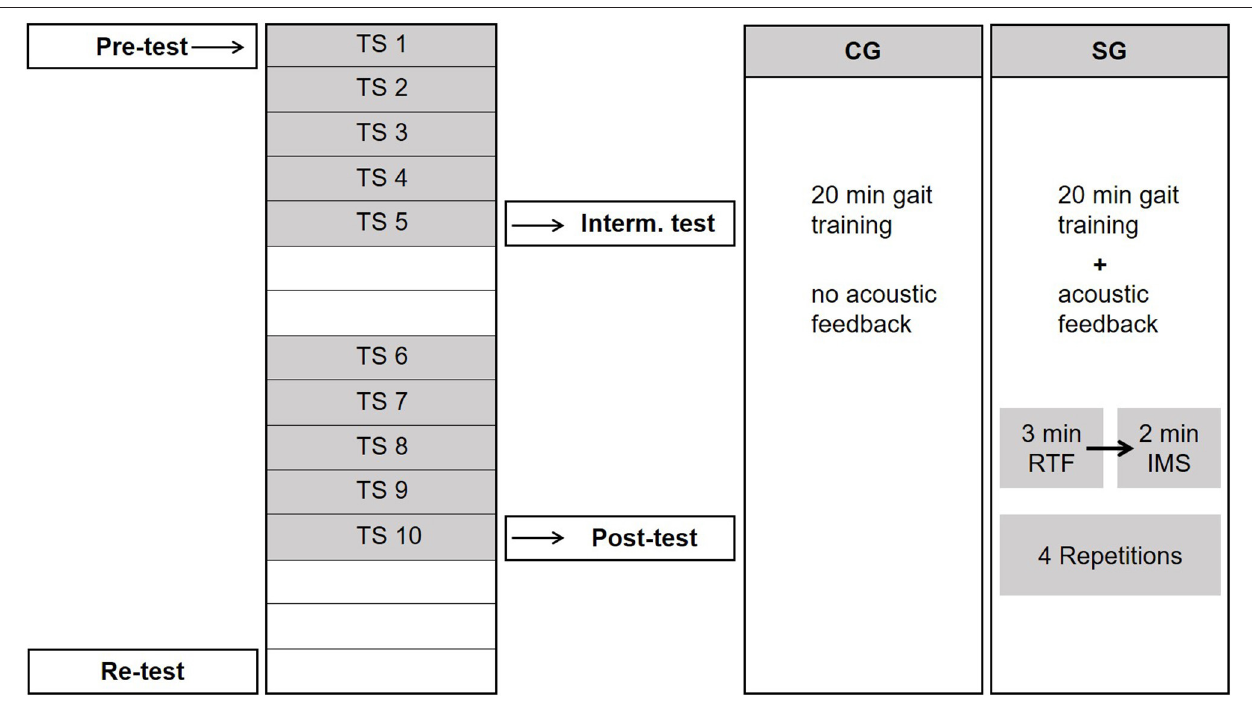
FIGURE 2 | Process of intervention with 10 training sessions (TS) spread over 12 days. The control group (CG) did not receive any acoustic feedback, while the sonification group (SG) received real-time feedback (RTF) alternating with instructive model sequences